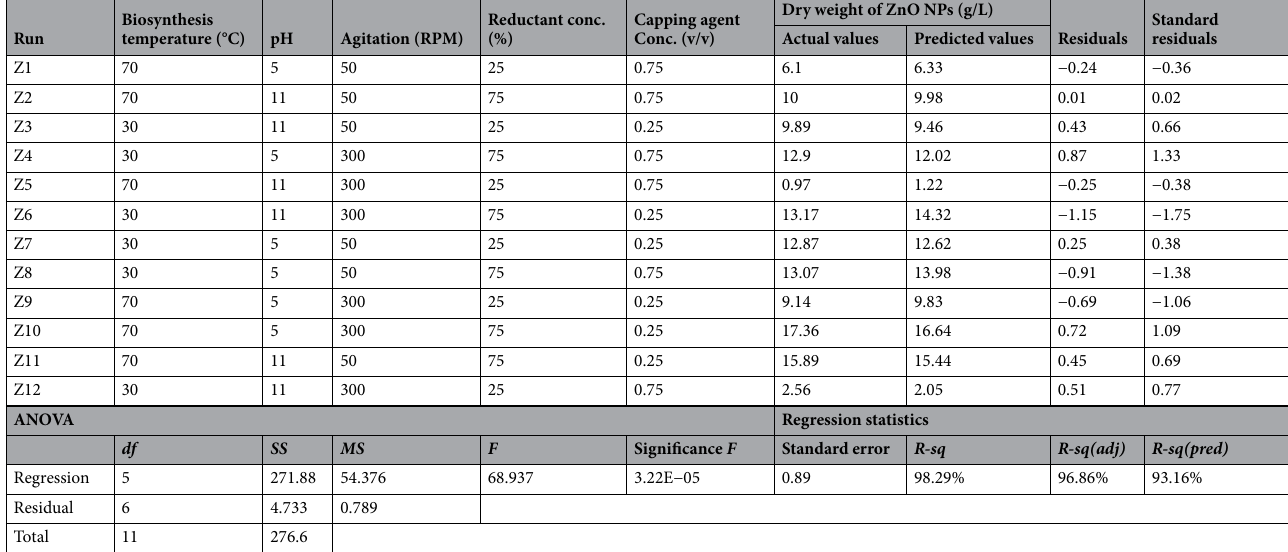
Table 3. Twelve trials of Plackett–Burman design to detect significant independent factors that influence ZnO NPs dry weight yield from the strain E56 cell-free extract.